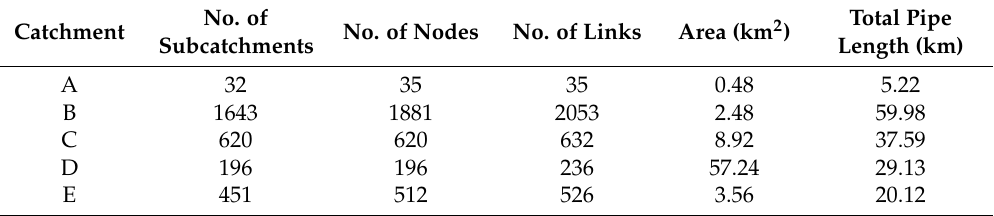
Table 2. Statistics of stormwater pipe networks in